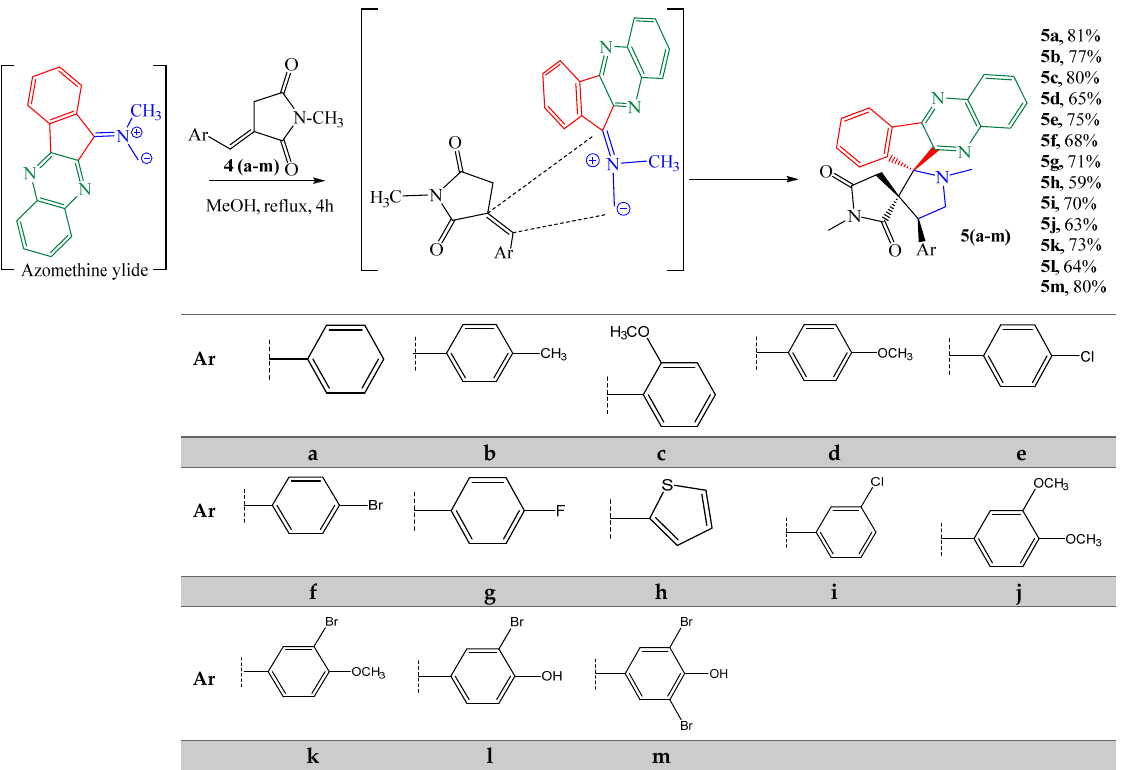
Table 1. Optimization of the reaction conditions.